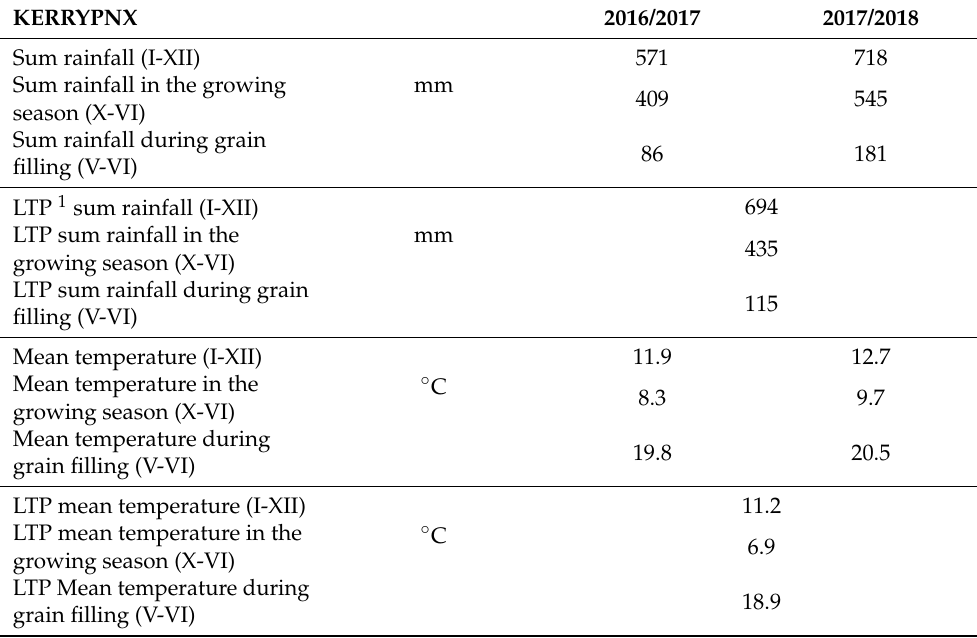
Table 3. Climatic data related to the growing